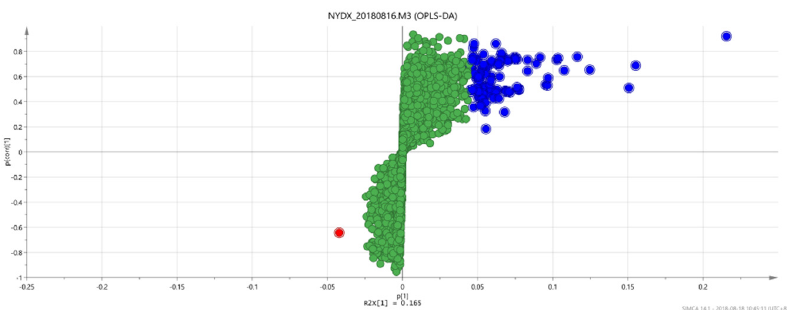
Figure 9. OPLS-DAS-plot diagram between group 1 and group 3. Note: Different colors indicate different correlations. The same below.